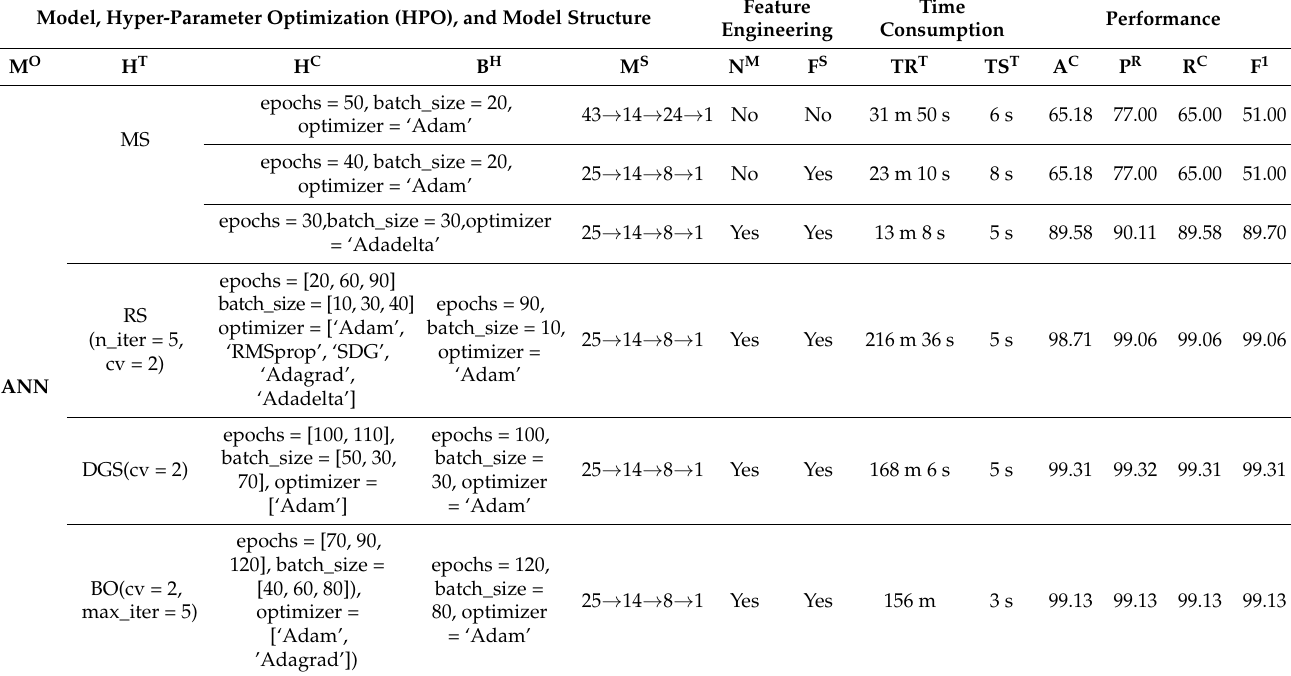
Table 7. Performance of deep learning model with manual hyper-parameter selection and through the utilization of exhaustive hyper-parameter optimization